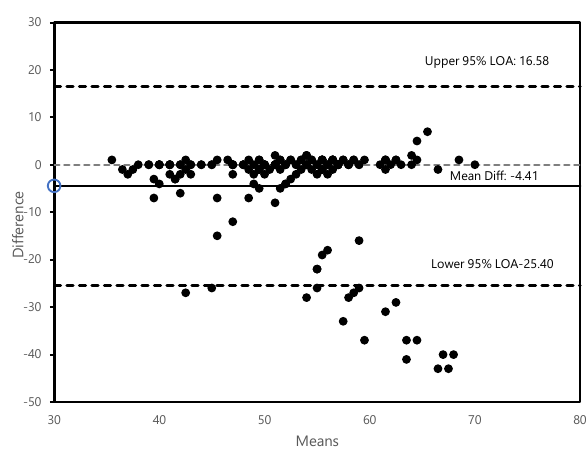
Figure 4 . Bland-Altman Plot for the Upper Arm ActiGraph Accelerometer. Positive Y-axis Values Indicate ActiGraph Upper Arm Push Counts that Were Less Than Manual Push Counts and Vice-versa.